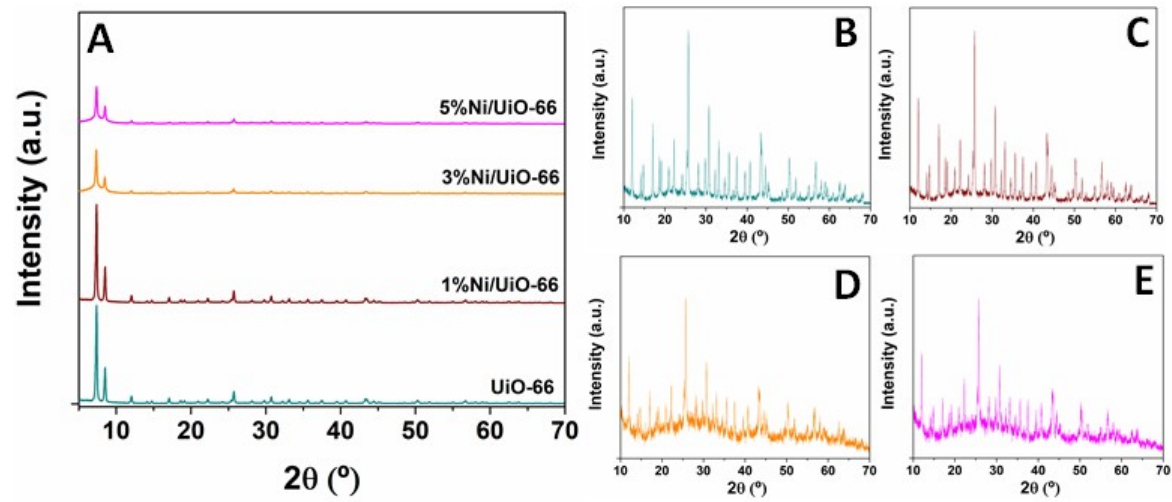
Figure 2. XRD patterns of the synthesized materials. ( A ) XRD diffractograms of all samples from 5° to 70°. Magnified XRD patterns from 10° to 70° for ( B ) UiO-66, ( C ) 1%Ni/UiO-66, ( D ) 3%Ni/UiO-66, ( E ) 5%Ni/ UiO-66.